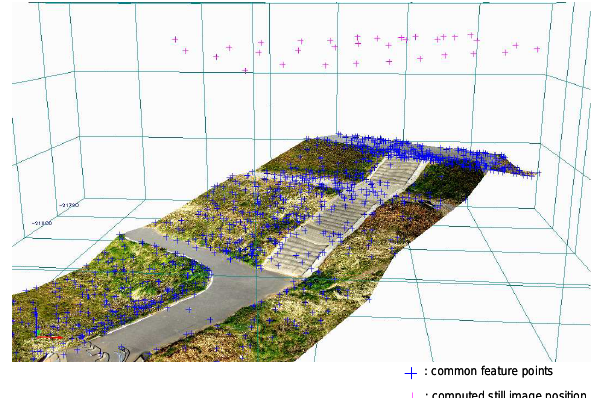
Figure 10. 3D model of First Flight